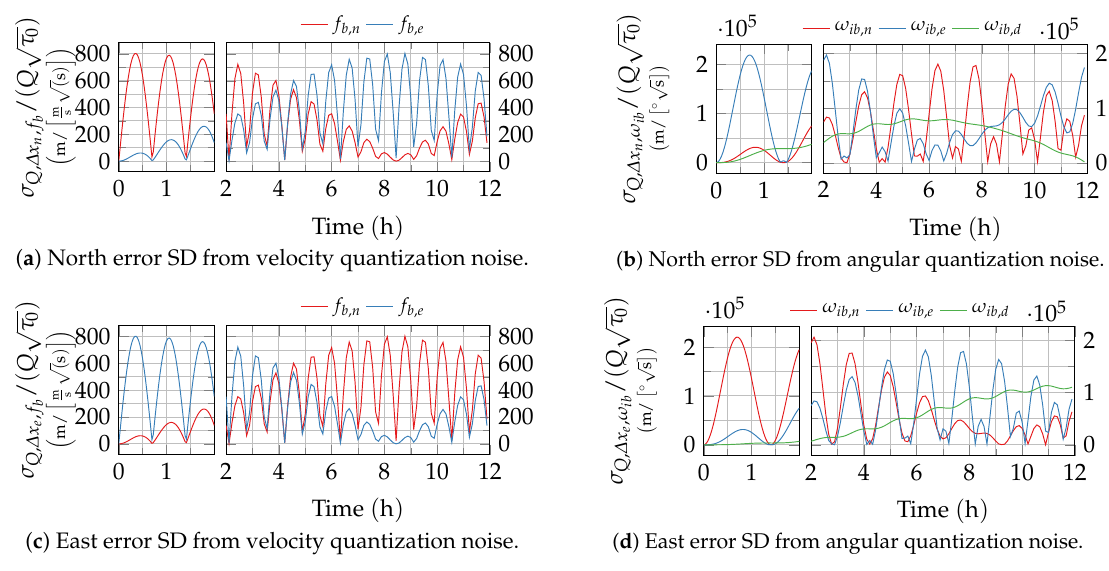
Figure 6. Position error growth from quantization noise. The time axis of the plots is split to provide a better resolution of the short-term